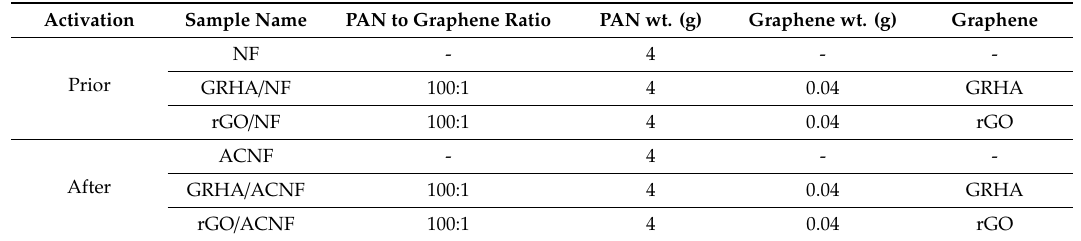
Table 1. Dope formulation of di ff erent graphene precursors of 50-mL